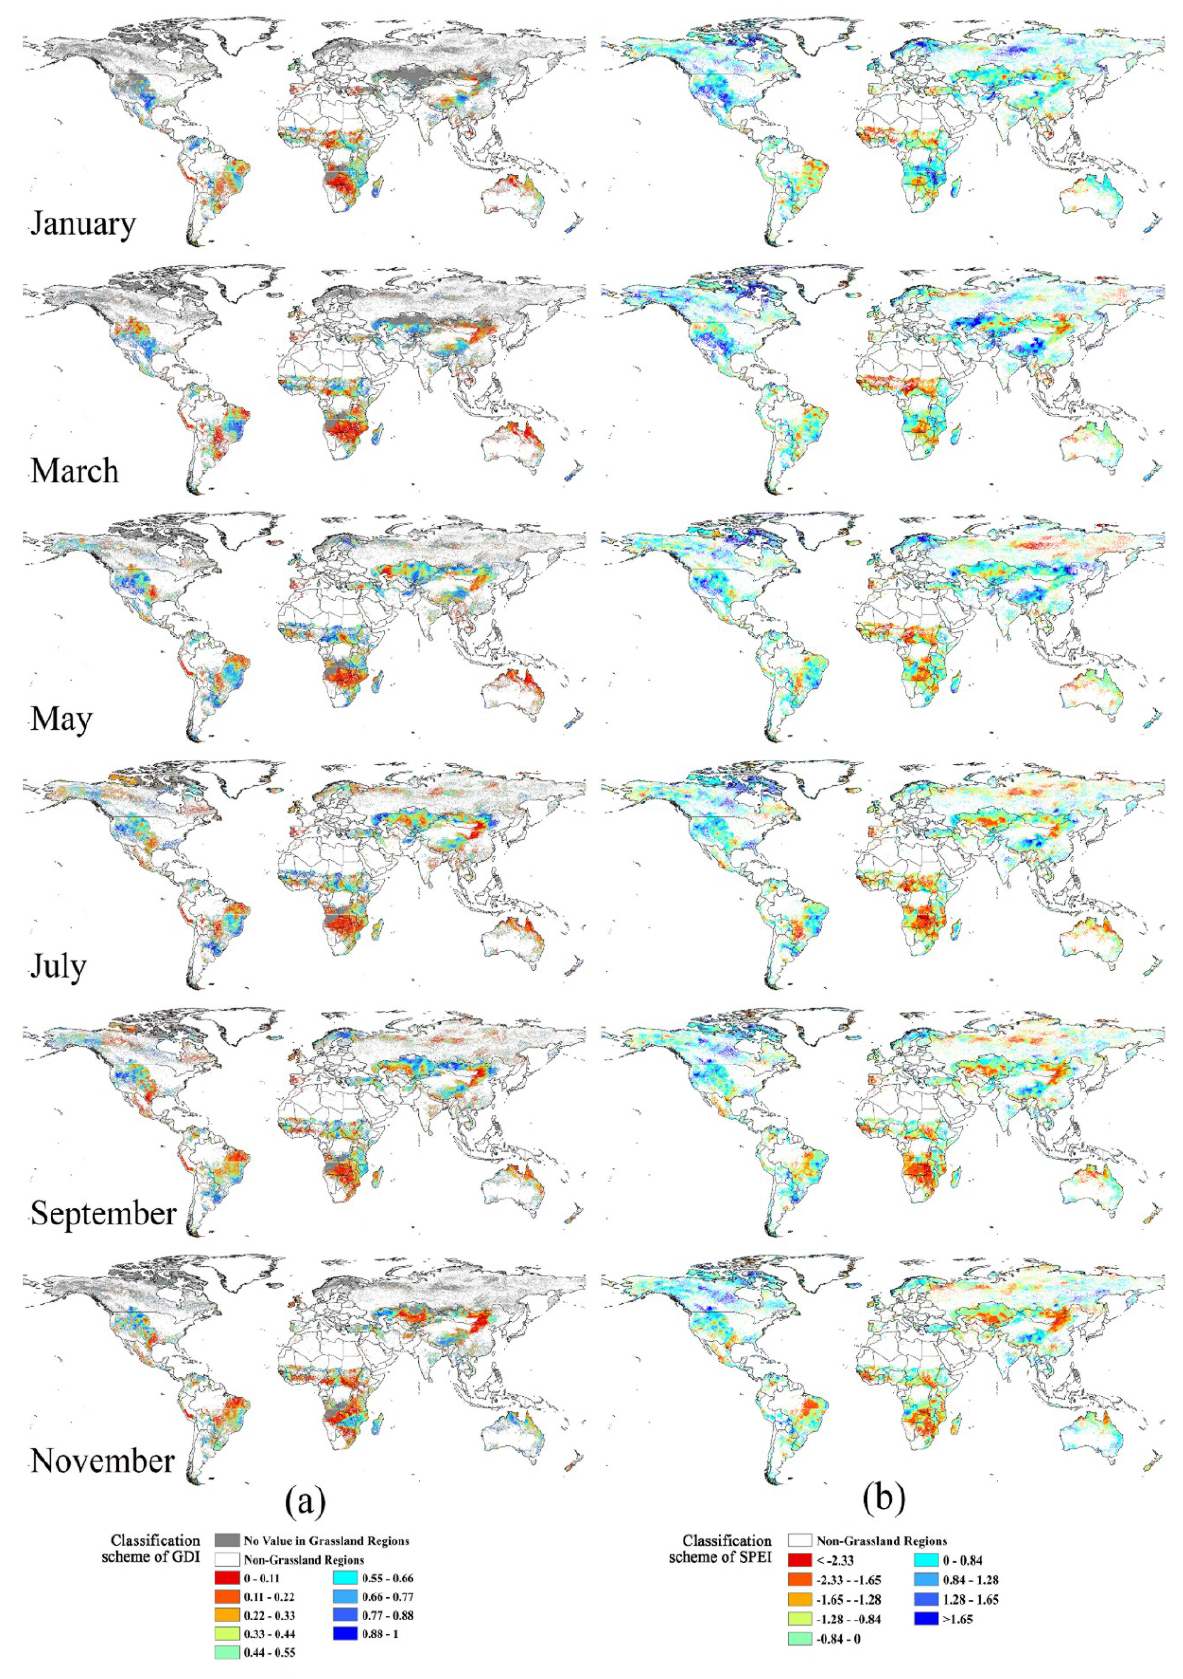
Figure 9. The global distribution of the GDI-6CRU and SPEI-6mon for grassland regions in different months of 2005. ( a ) GDI-6CRU; ( b )